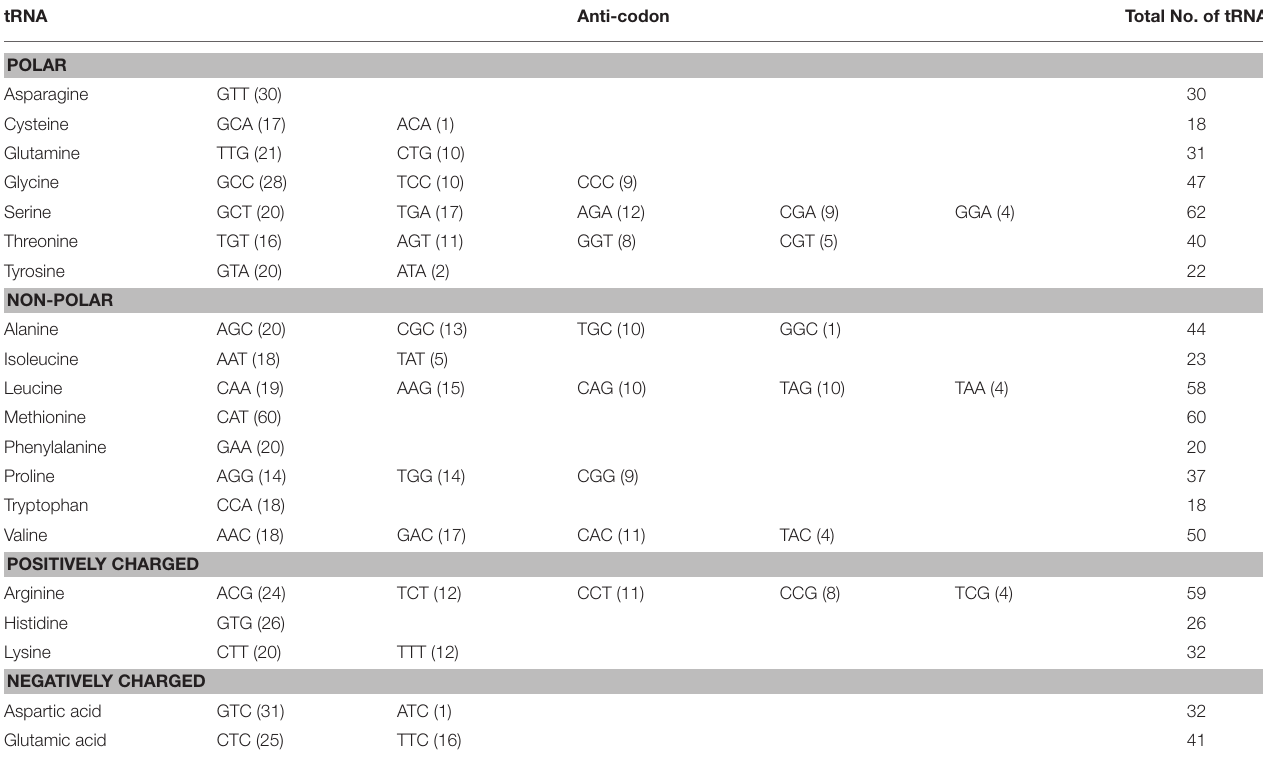
TABLE 1 | Detail of O. sativa tRNA and anti-codon nucleotide sequences. O. sativa encodes maximum of 62 tRNA Ser in its genome with five different anti-codons. tRNA Anti-codon Total No. of